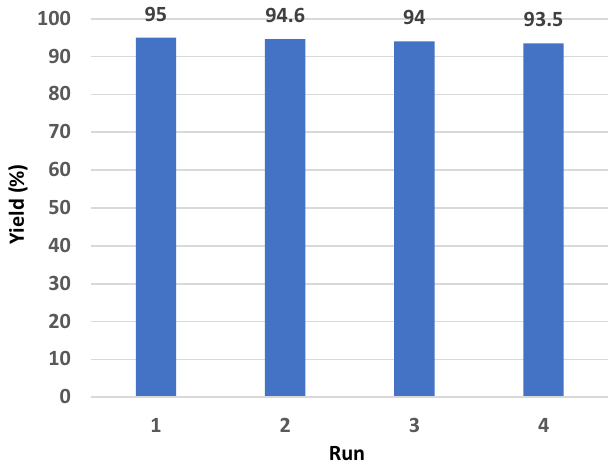
Figure 6. Reusability of the MCM-41-SO 3 H catalyst in four consecutive runs.